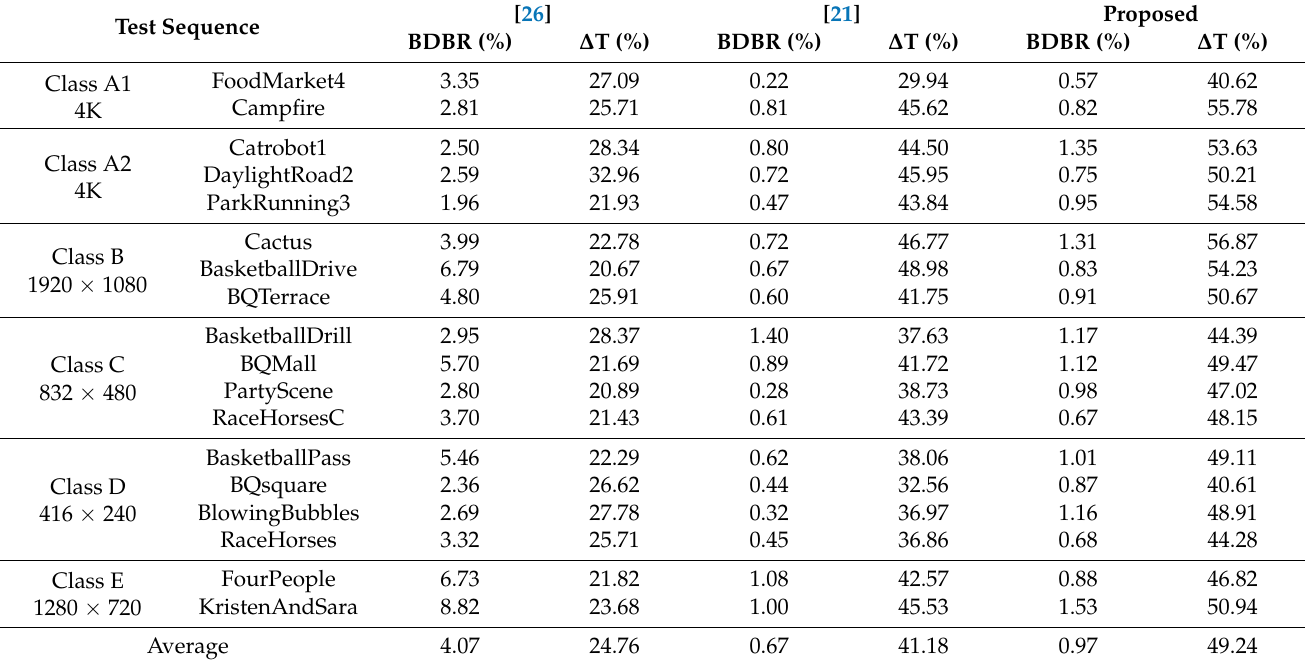
Table 3. Performance of the proposed